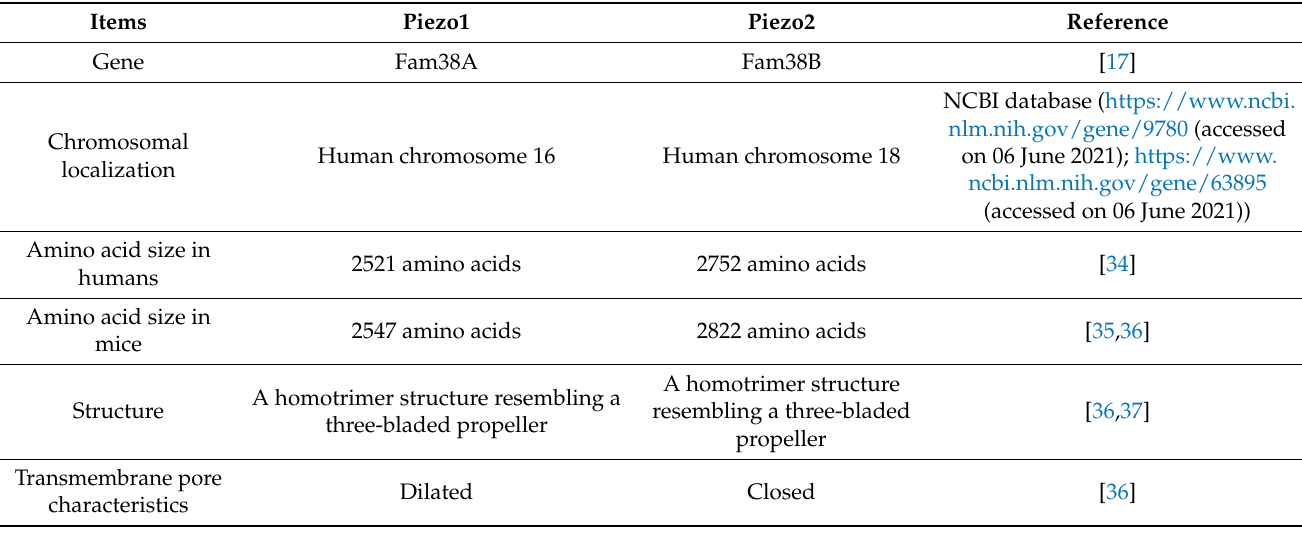
Table 1. The similarities and differences between Piezo1 and